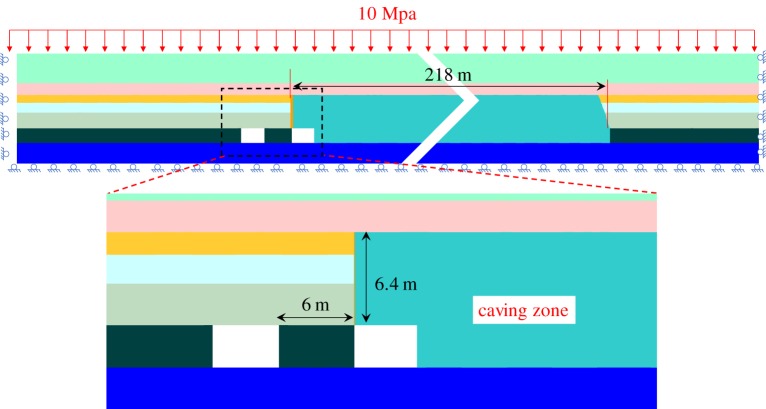
The numerical model.